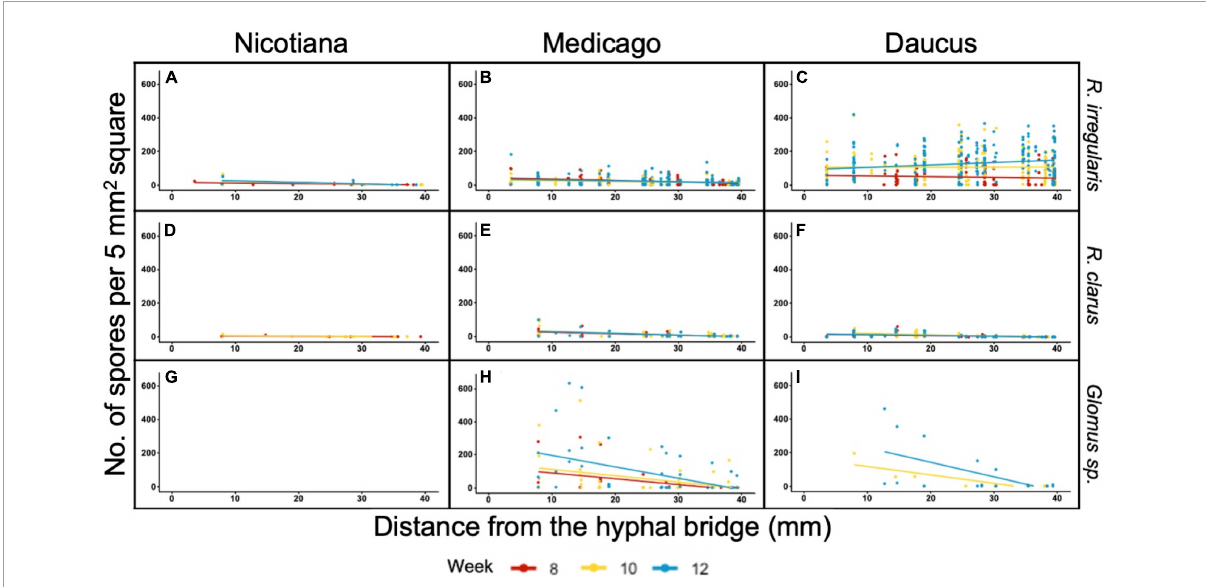
FIGURE4 Distribution of spore counts scored in 5 mm 2 grid squares in relation to their distance from the hyphal bridge. Regression lines were fit to spore counts recorded at 8 wpi (red), 10 wpi (yellow), and 12 wpi (blue). Panel columns are arranged by host (left to right: Nicotiana, Medicago, and Daucus) and rows are arranged by AMF (top to bottom: R. irregularis, R. clarus, and Glomus